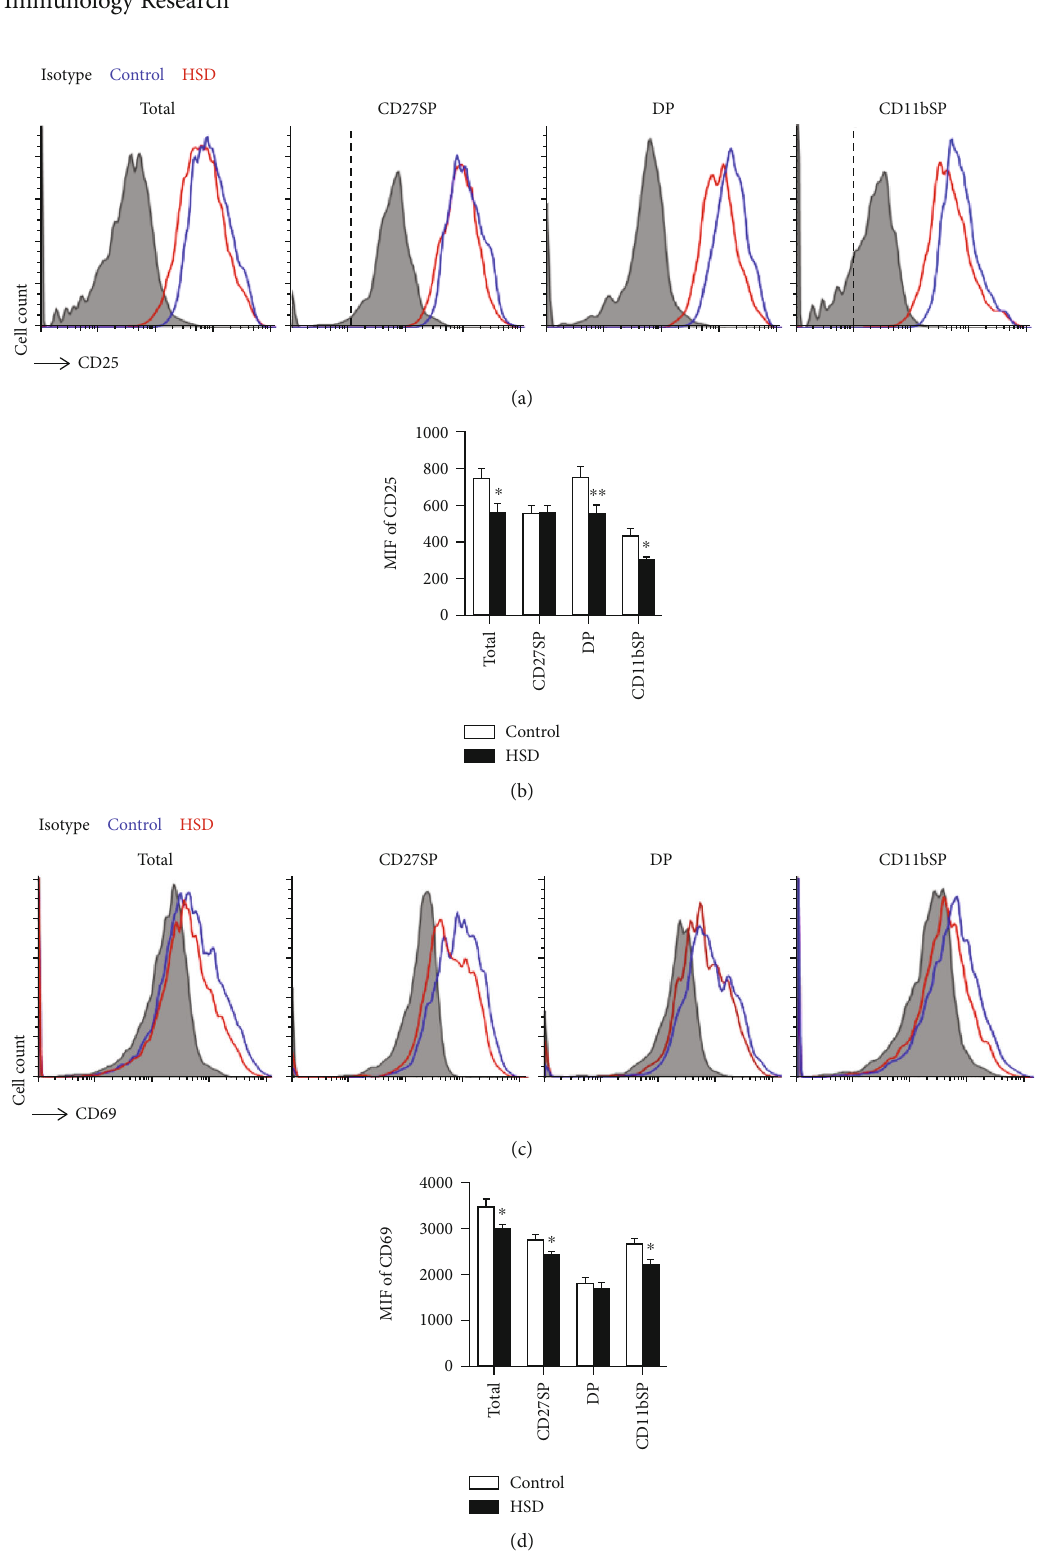
Figure 6: HSD decreases NK cell activation. Expression of the activation marker, CD25, in splenic NK cells from control and HSD-fed mice was assessed during di ff erent developmental stages (a). The mean fl uorescence intensity of CD25 in NK cells (b). Expression of the activation marker, CD69, in splenic NK cells from control and HSD-fed mice was assessed during di ff erent developmental stages (c). The mean fl uorescence intensity of CD69 in NK cells (d). All the data represent at least three independent experiments. Data are shown as the means ± SEM . Unpaired Student ’ s t -tests (two-tailed) were performed using the Prism software. A P value of < 0.05 was considered signi fi cant. ∗ P < 0 : 05 , ∗∗ P < 0 : 01